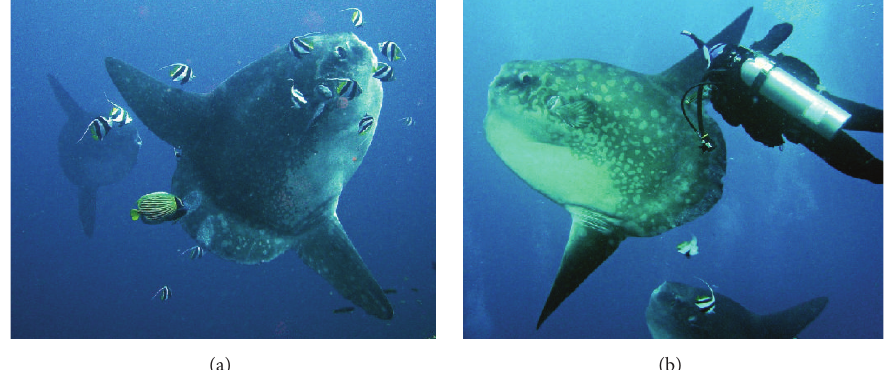
Figure2:(a)1mTL Mola ramsayi beingcleaned25–30 m,NusaPenida,Bali.(b)Diver,BrettHobson,insertingsatellitetaginto Mola ramsayi , Crystal Bay, Nusa Penida, Bali, 11 October 2008. Photo: Sven Fautz.